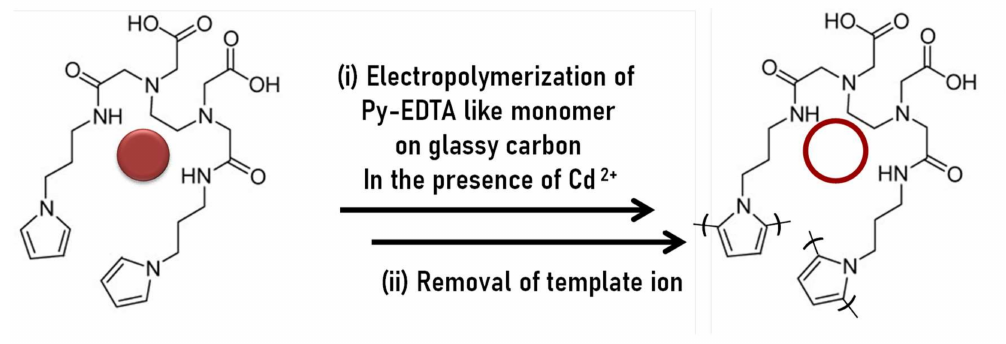
Figure 15. Preparation of Cu(II) imprinted poly(pyrrole-EDTA like) polymer for the selective detec-